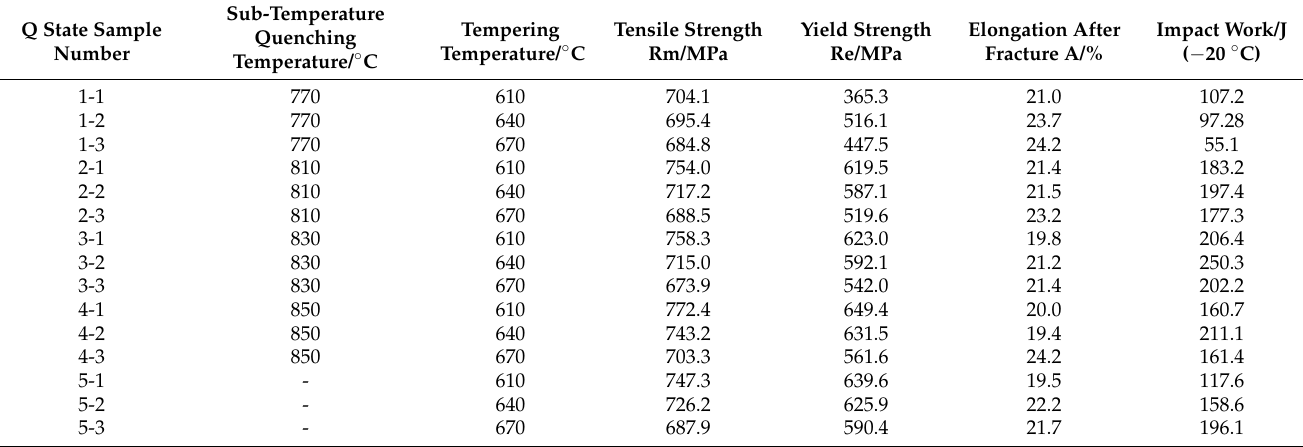
Table 6. C Statistical table of mechanical properties of C quenched sample after sub-temperature